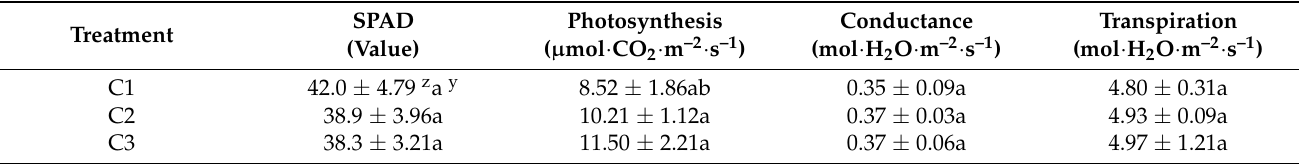
Table 4. Effect of container size on SPAD, photosynthetic rate, stomatal conductance, and transpiration rate of M-9 apple rootstock plant at 11 weeks after treatment. C1, C2 and C3 indicate container size of 1000 mL, 500 mL and 300 mL, respectively.